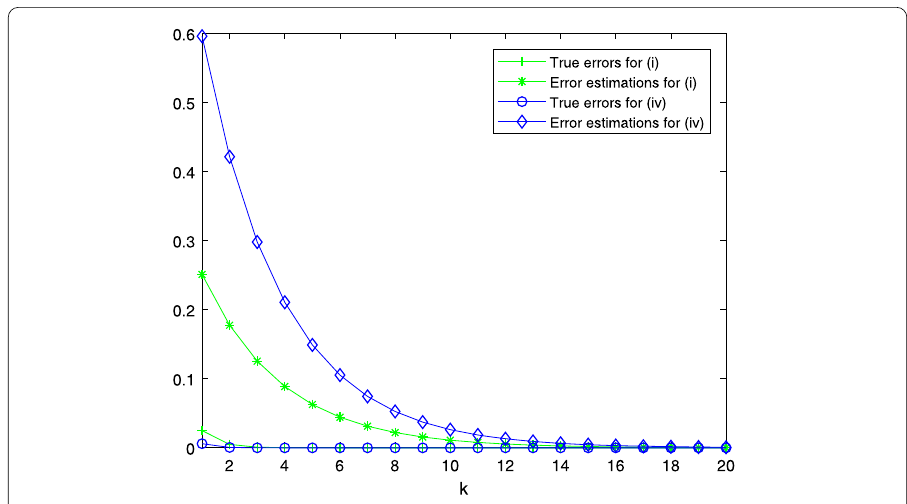
Figure 2 Illustration of true errors (cid:2) x k – x ∗ (cid:2) (see 1 ≤ k ≤ 20) and error estimations for Mann iteration (i) and Ishikawa iteration (iv) with x 0 =